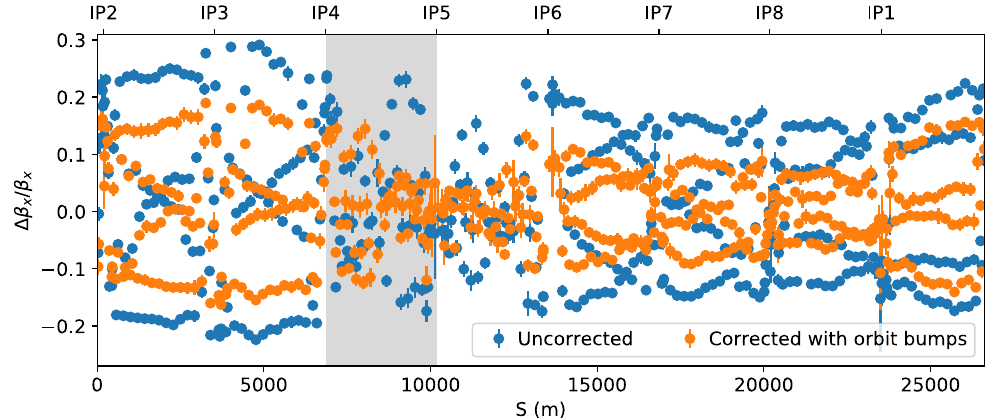
FIG. 19. Measurement of the effect on the horizontal β -beating of Beam 1 of the correction with orbit bumps in sextupoles performed during the flat optics MD that took place in 2018. The previous global corrections calculated during 2017 were removed. The grey area is the region of the accelerator targeted by the correction. The 24% peak in arc 45 was reduced to about 5% and the overall β -beating around the machine was reduced about Table III the orbit correction and trim of MQML.10R4.B1 used to produce the knob are shown.